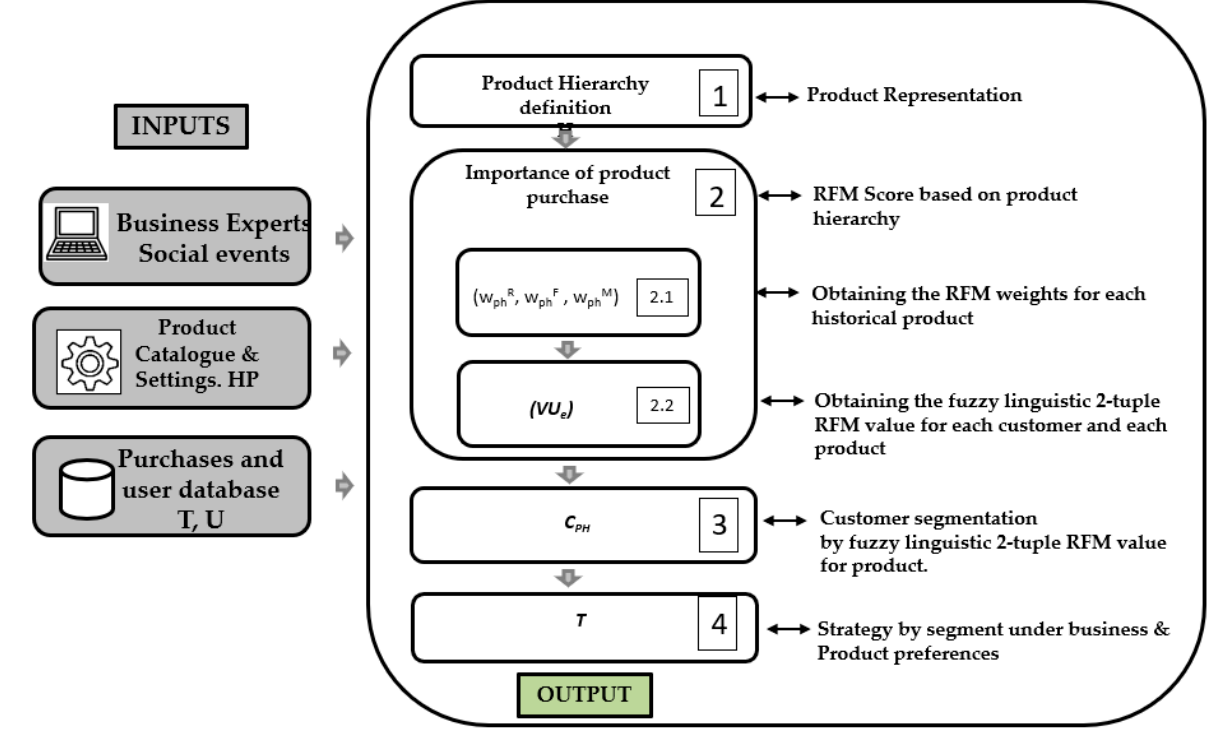
Figure 3. Overview of our proposed model.